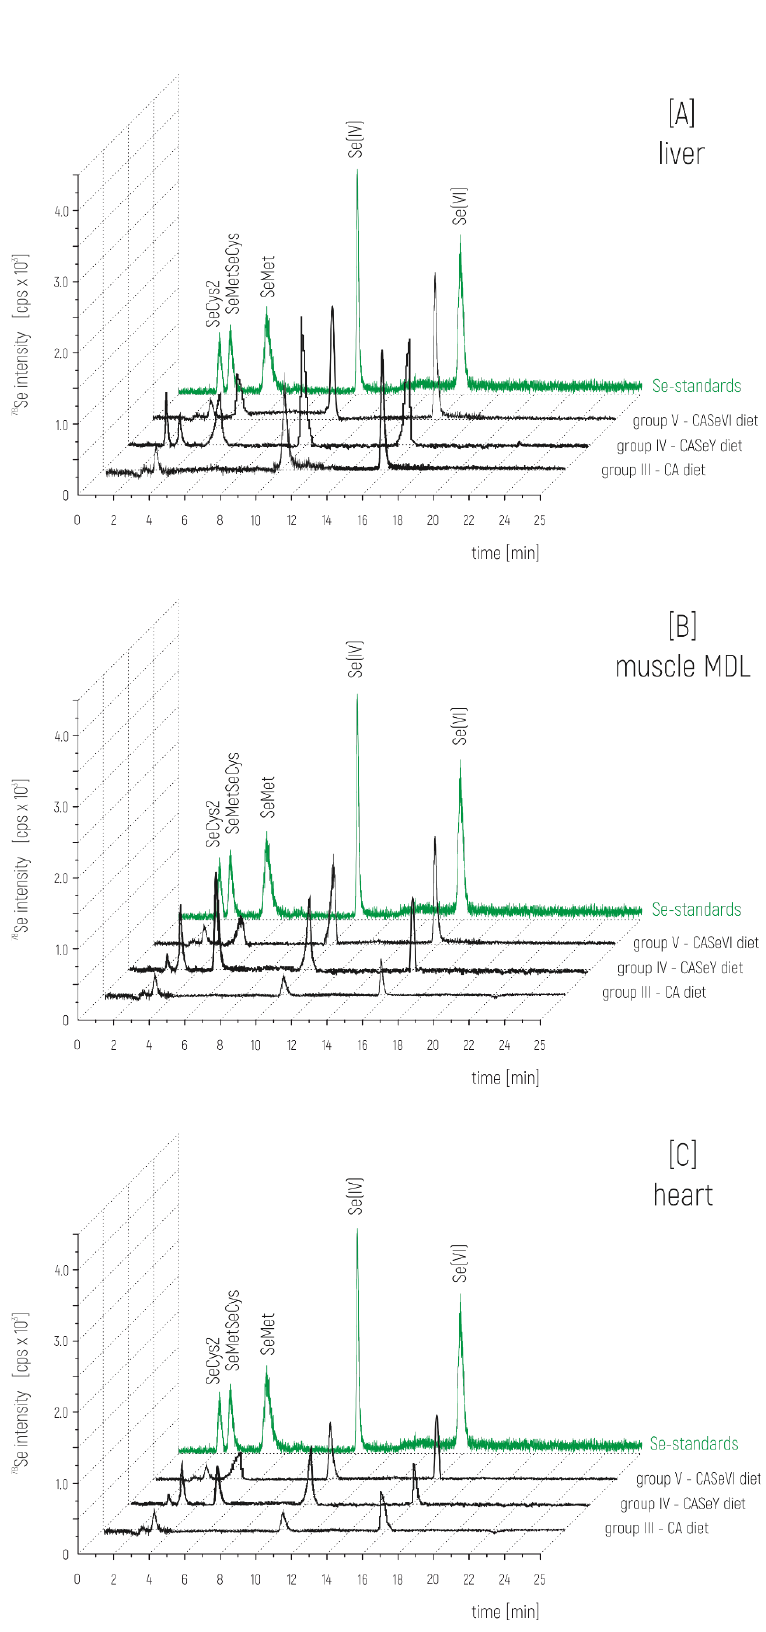
Figure 1. Chromatograms of 78 Se signal obtained using HPLC – ICP – MS for analysis of ( A ) liver, ( B ) muscle MDL (longissimus dorsi muscle), and ( C ) heart from lambs, after supplementation with Se- compounds.